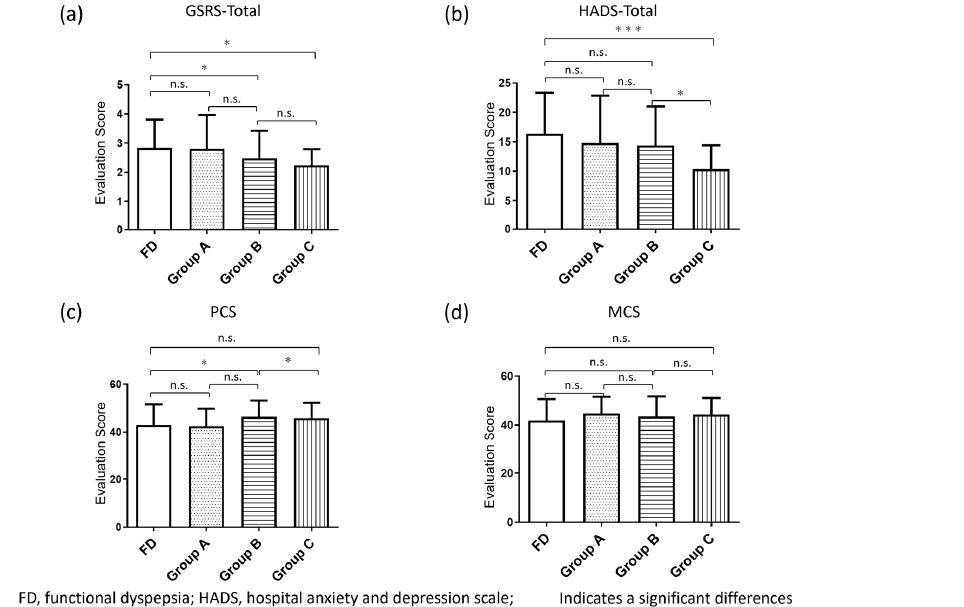
Figure 4. GSRS, psychological and general QOL score in subdivision of non-FD patients. ( a ) The overall scores of the GSRS for Group A and the FD group are comparable, whereas those of Group B and Group C were significantly lower than that of the FD group; ( b ) The overall psychological scores for Group A and Group B are not significantly different from that of the FD group, but the Group C score is significantly lower than that of the FD group; ( c , d ) The physical component summary scores of general QOL for Group A and Group C are not significantly different from that of the FD group, but the score of Group B is significantly higher than that of the FD group. Furthermore, the mental component summary scores of Group A, Group B and Group C are not significantly different from that of the FD group.